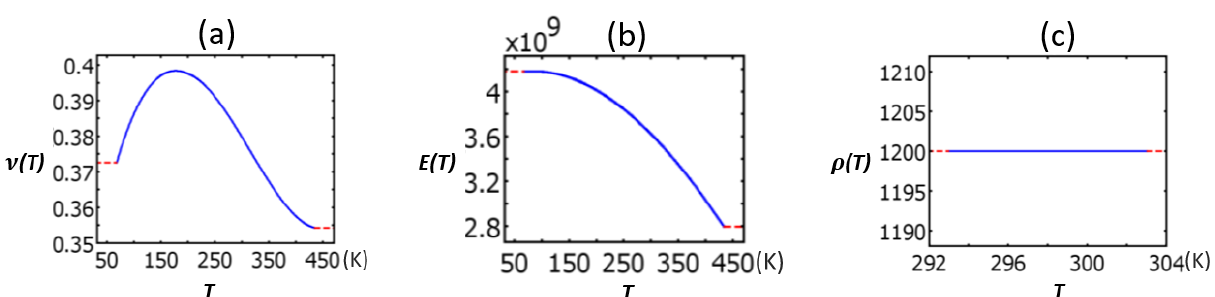
Figure 4. Polycarbonate’s Poisson’s ratio ( a ), elastic modulus ( b ), and density ( c ).